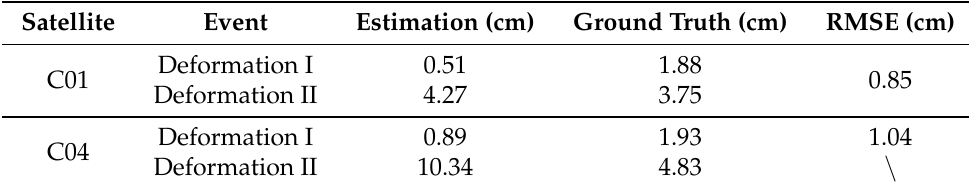
Table 3. Deformation estimation results for both